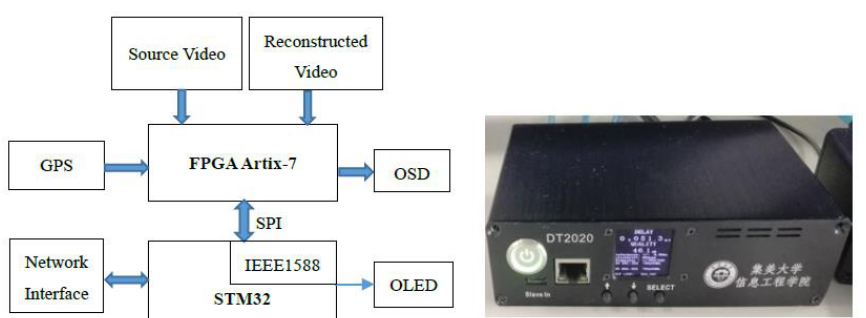
Figure 8. Design framework and physical and picture of delay measurement equipment. The picture contains Chinese words: “ School of Information Engineering, Jimei University ”.